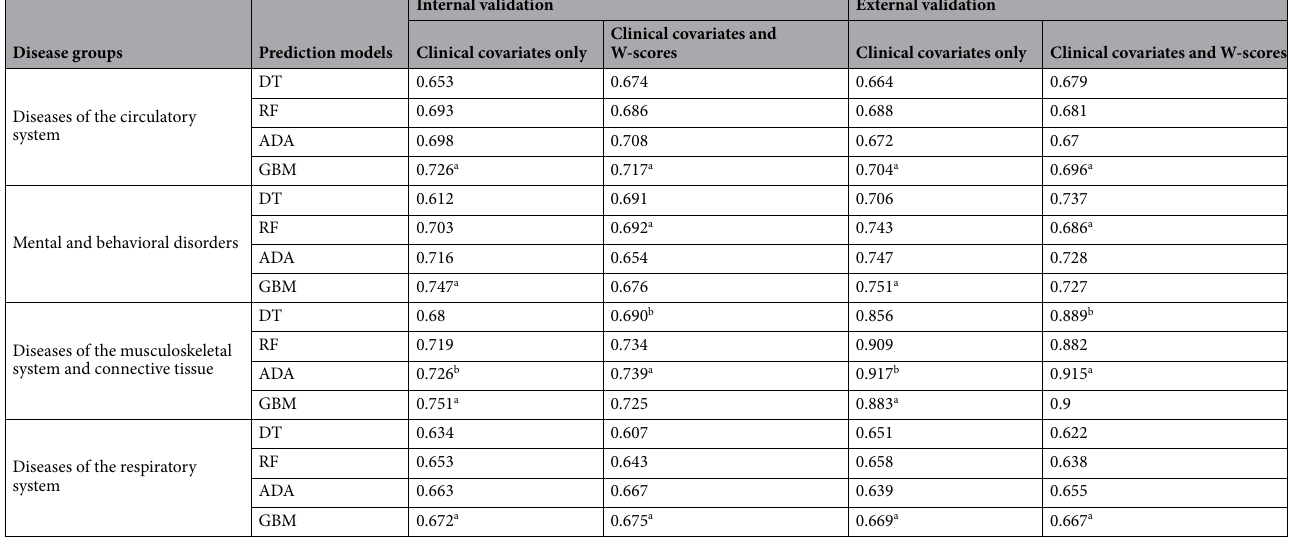
Table 3. Comparison of disease-specific performance in each model based on the area under the receiver operating characteristic curve. a Best performances for each disease. b Major improvements in external validation.